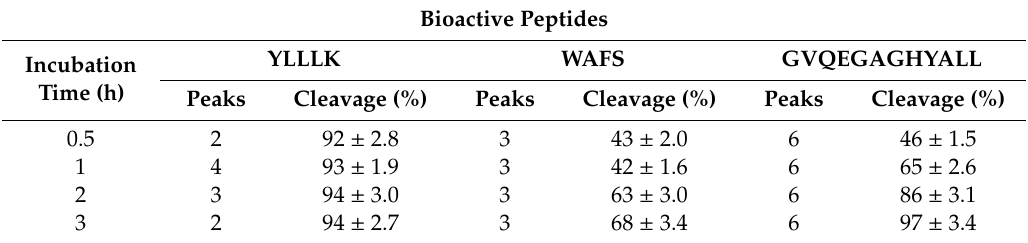
Table 2. Hydrolysis of papain-generated peptides by angiotensin-converting enzyme (ACE) with incubation for 3 h.